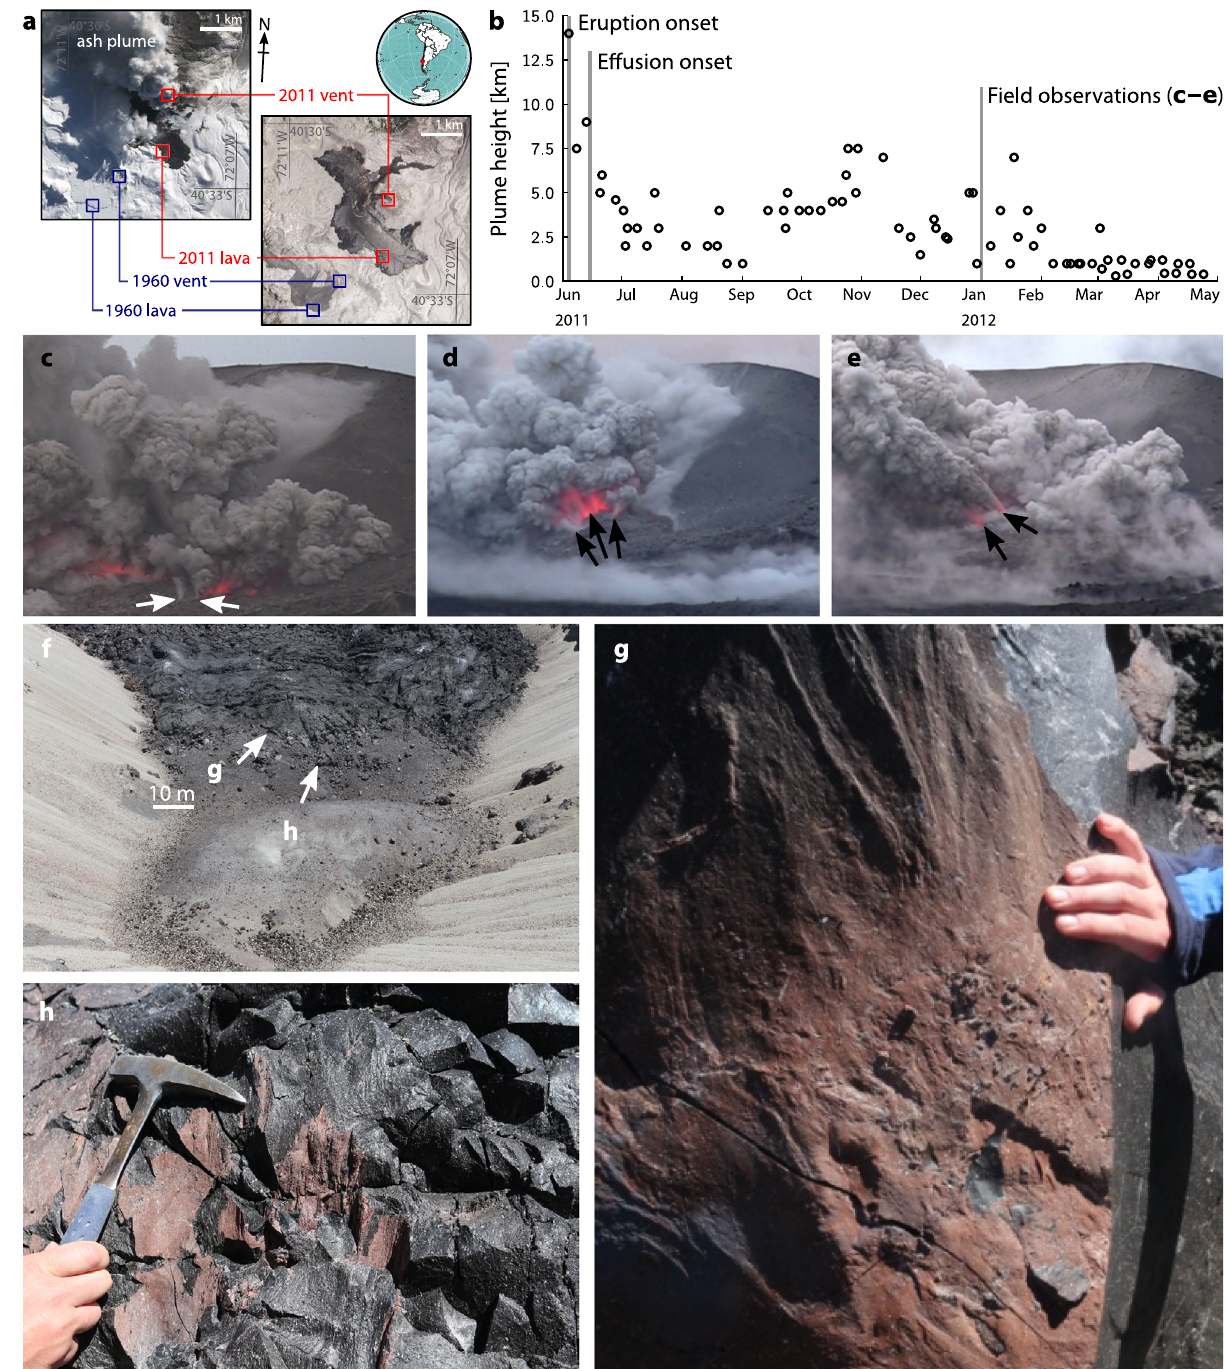
Onset of effusion (i.e. hybrid phase) is highlighted, as is the date of on-site obser- vationsshownin c – e . c – e VideoframesrecordedinJanuary2012showingthemain Cordón Caulle vent region. Arrows highlight discrete, semi-transient ash vents. f Vent region in 2014. g Detail of reddish veneer coating curviplanar ash-vent sur- face (see ( f ) for location). h As ( g ), detailing ash veneer on hackly lava